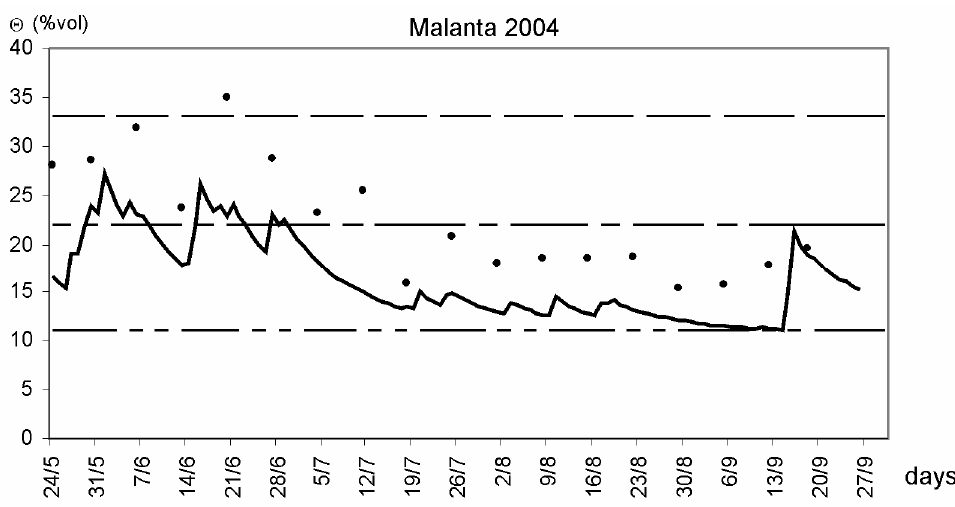
Fig 6. Measured and simulated values of volumetric soil water content in study area of Malanta in